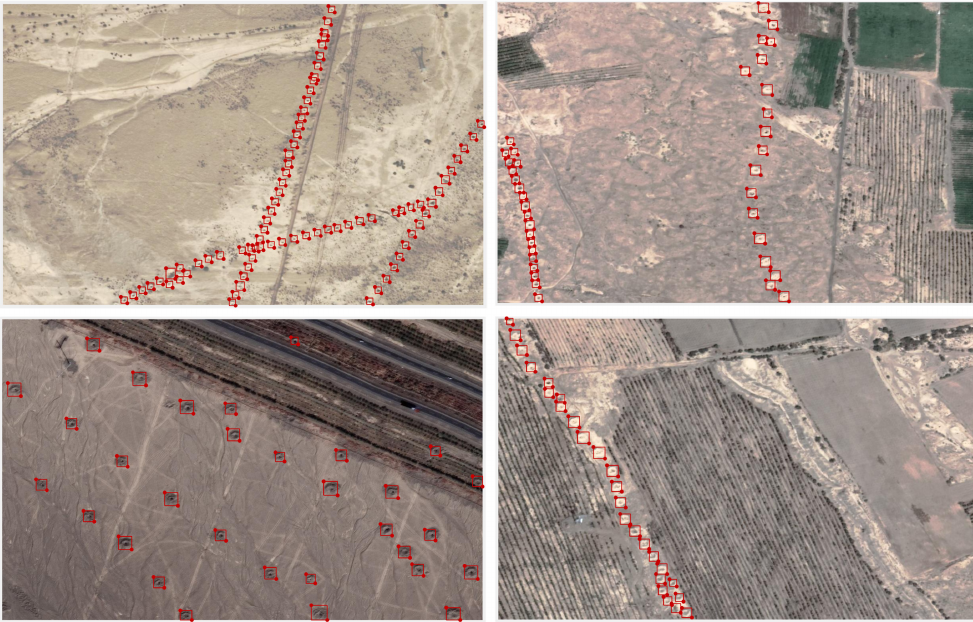
Figure 5. Sample dataset of karez. The red rectangular box is the labeled box of the karez